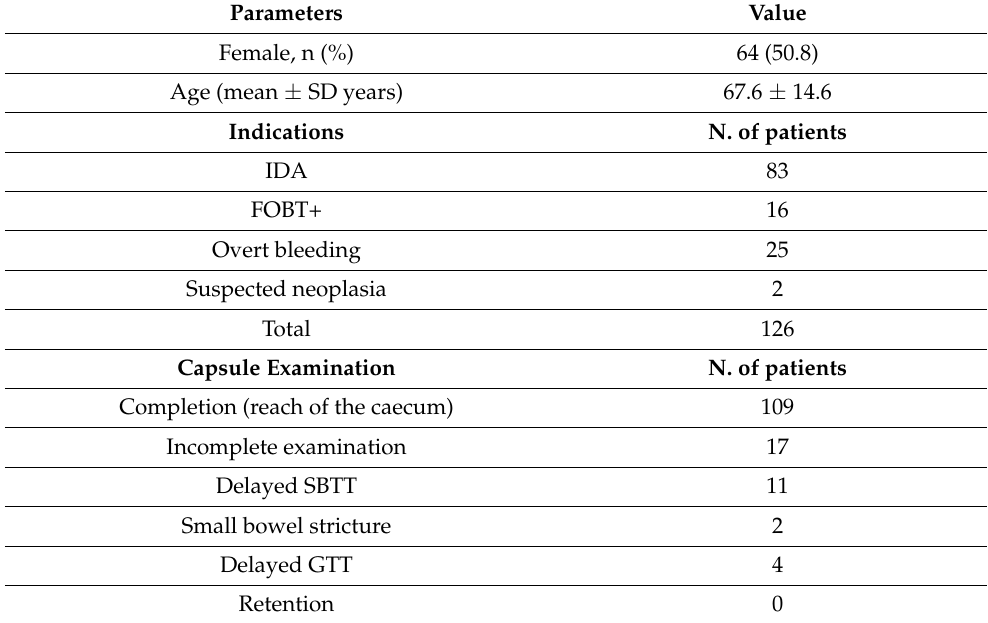
Table 1. Study population and